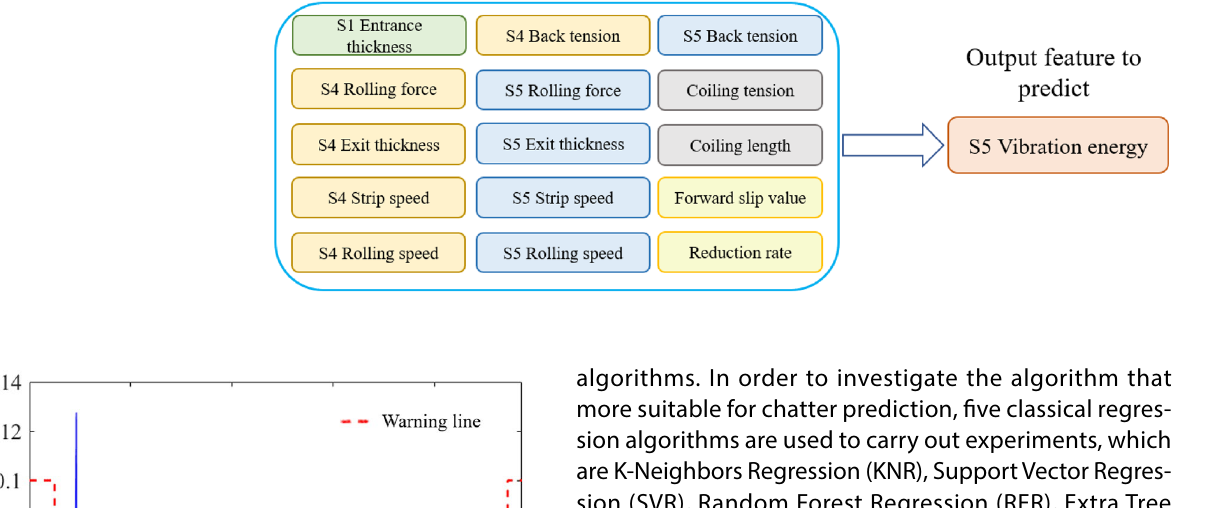
Fig. 6 Sample space